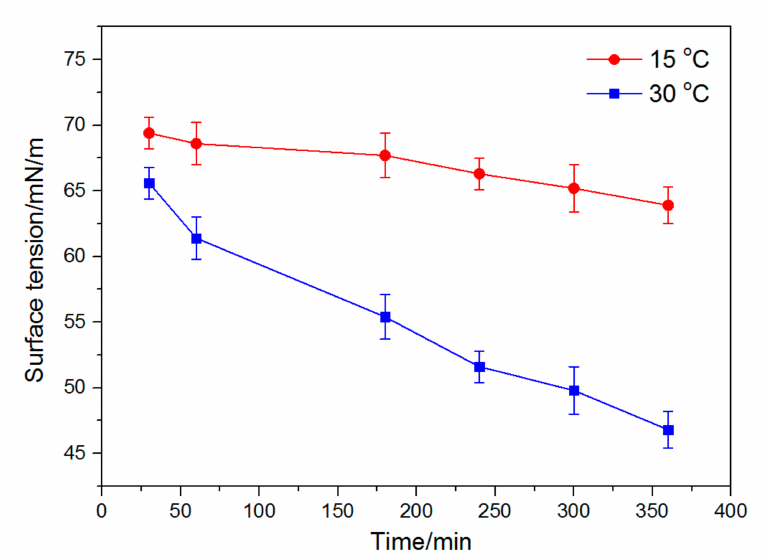
Figure 5. Surface tension of p (ASF-AGE-NIPAAm) spinning solution with different polymerization times at 15 and 30 ◦ C.